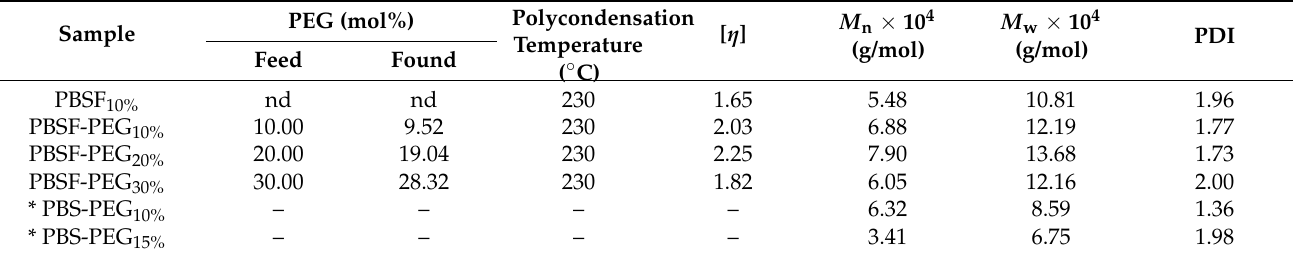
Table 1. Molecular structures, reaction condition, molecular weight of copolyesters, and PEG content calculated from the 1 H NMR integral values.